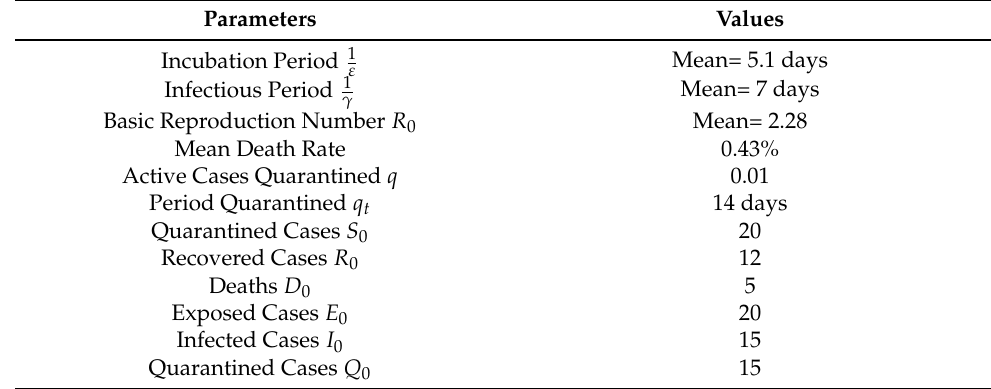
Table 1. List of parameters and functions